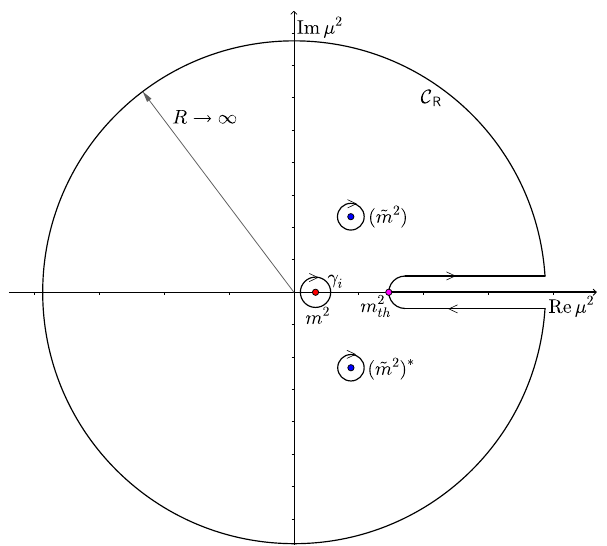
Figure 1 . Integration contour for eq.